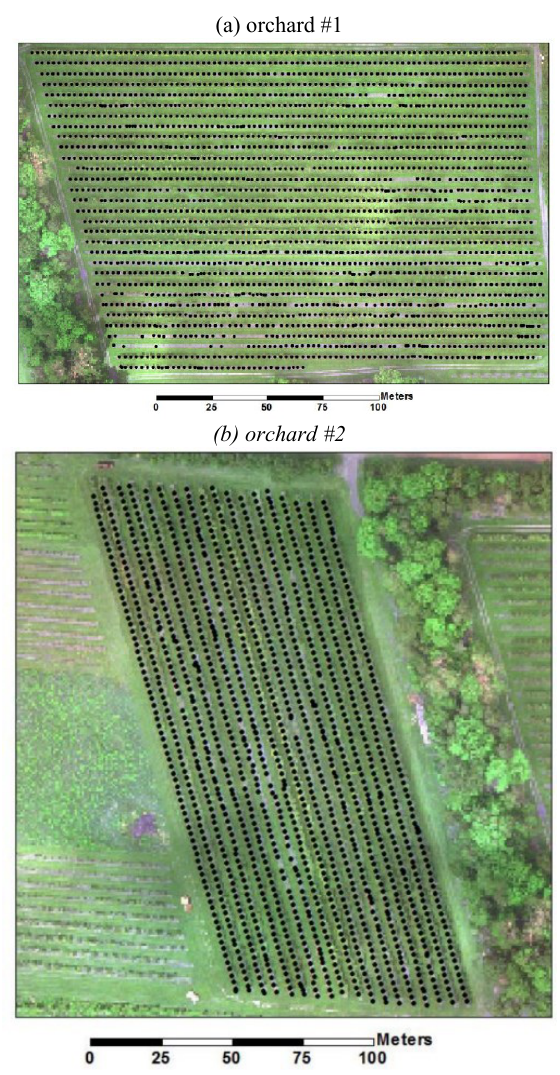
Figure 9. Detected trees in (a) Orchard#1 and (b)